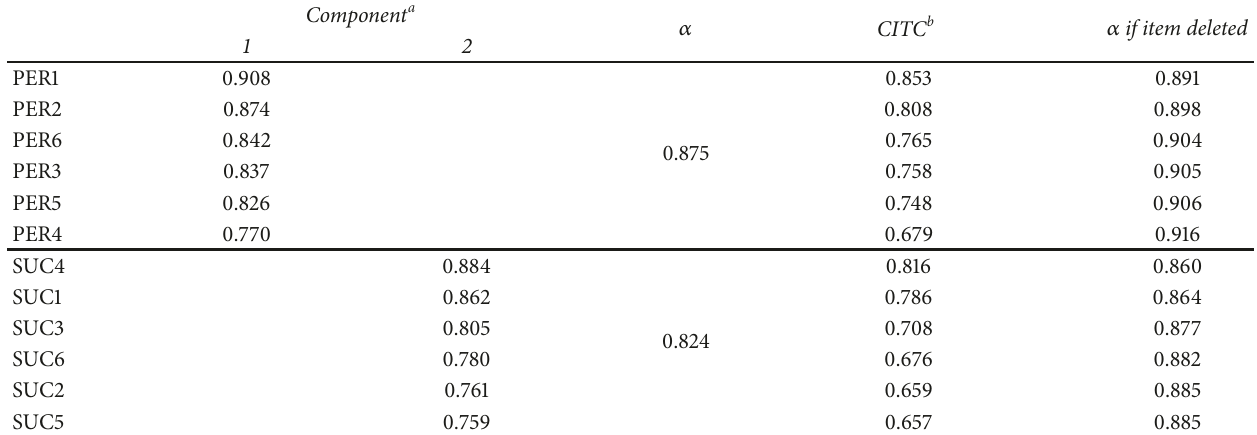
Table 5: EFA rotated matrix of dependent variables and reliability analysis.